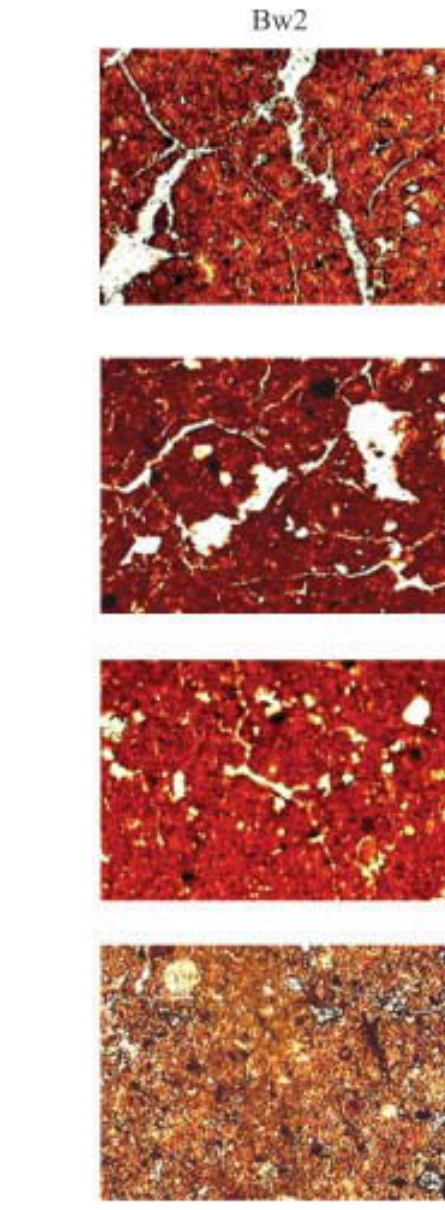
Figura 1. Microfotografia dos horizontes Bw1 e Bw2 do Latossolo Bruno ácrico húmico de diferentes perfis na toposseqüência (detalhes da posição dos perfis na paisagem - Quadro